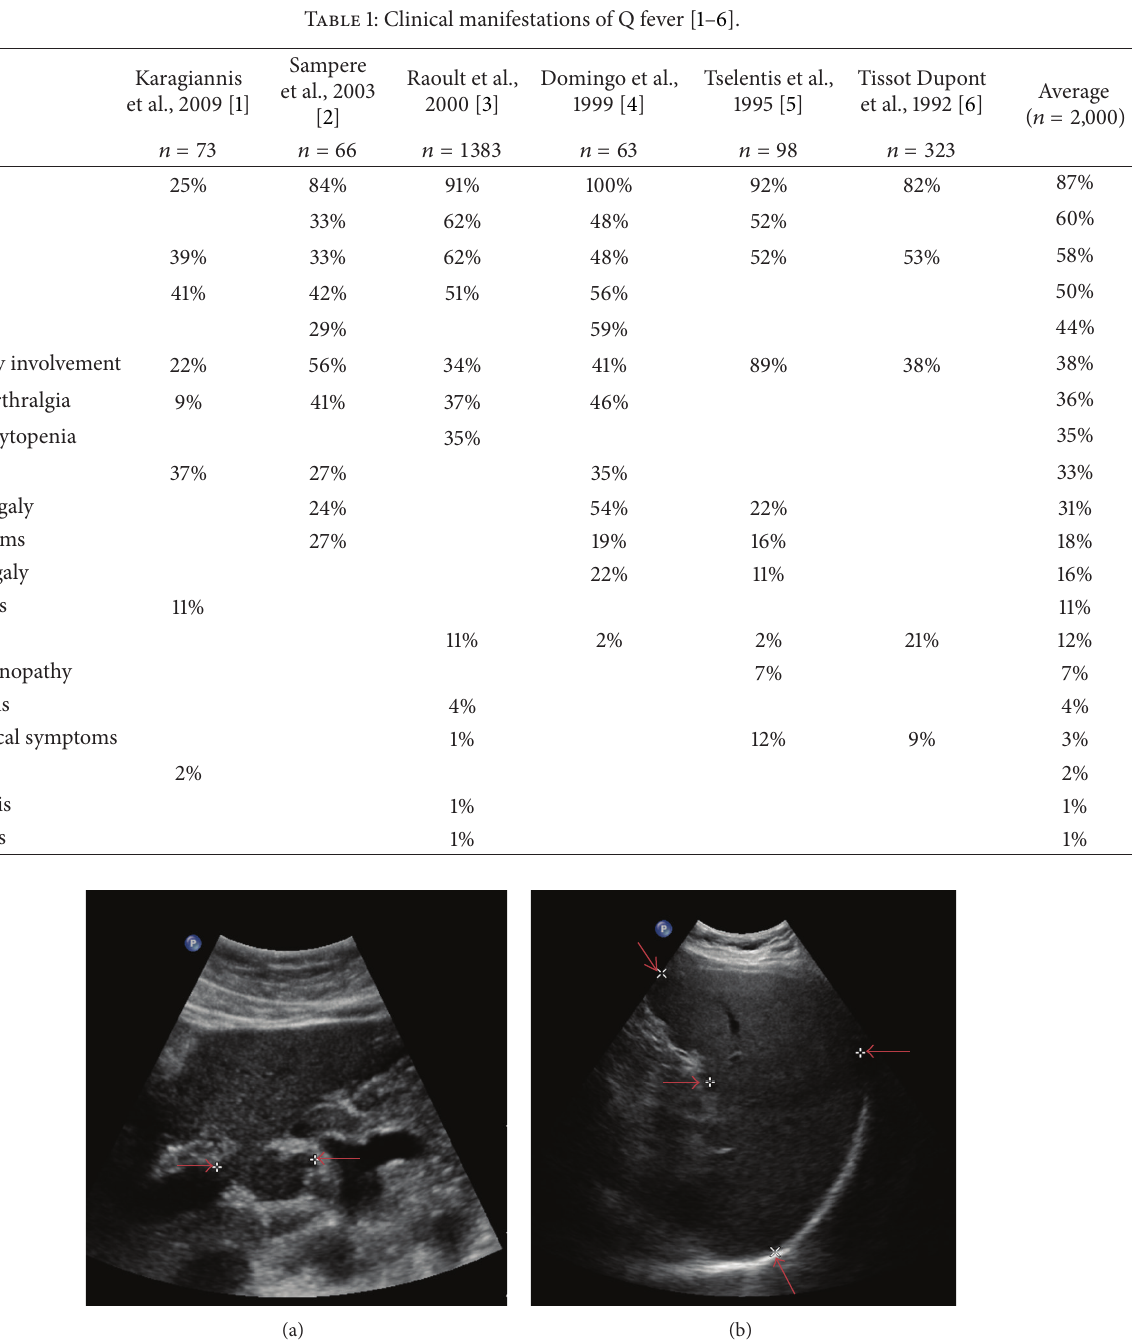
malignancy. Flow cytometry of the lymph node and bone marrow showed no